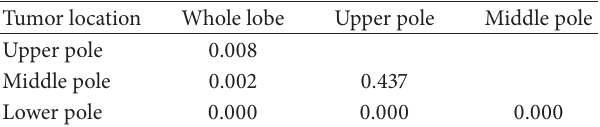
Table 5: The statistical analysis among groups grouped by tumor